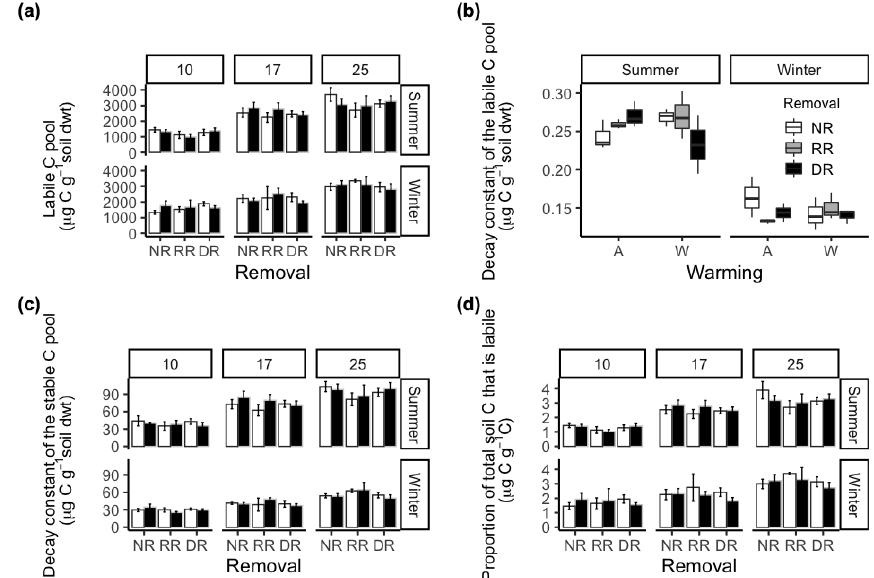
Figure 6. (a) Labile C pool size ( C a ) in summer and winter soils in no removal (NR), random removal (RR), and dominant removal (DR) plots at incubation temperature: 10, 17, and 25 ◦ C for warmed (black) and ambient (white) treatments. (b) Intrinsic decay constant of the labile C pool ( k ) for both summer and winter soils in no removal (NR), random removal (RR), and dominant removal (DR) plots at incubation temperature: 10, 17, and 25 ◦ C for warmed (black) and ambient (white) treatments. (c) The intrinsic decay constant of the stable C pool ( Y 0 ) in summer and winter soils in no removal (NR), random removal (RR), and dominant removal (DR) plots at incubation temperature: 10, 17, and 25 ◦ C for warmed (black) and ambient (white) treatments. (d) Proportion of total C that is from the labile C pool ( C a ) in both summer and winter soils in no removal (NR), random removal (RR), and dominant removal (DR) plots at incubation temperature: 10, 17, and 25 ◦ C for warmed (black) and ambient (white)